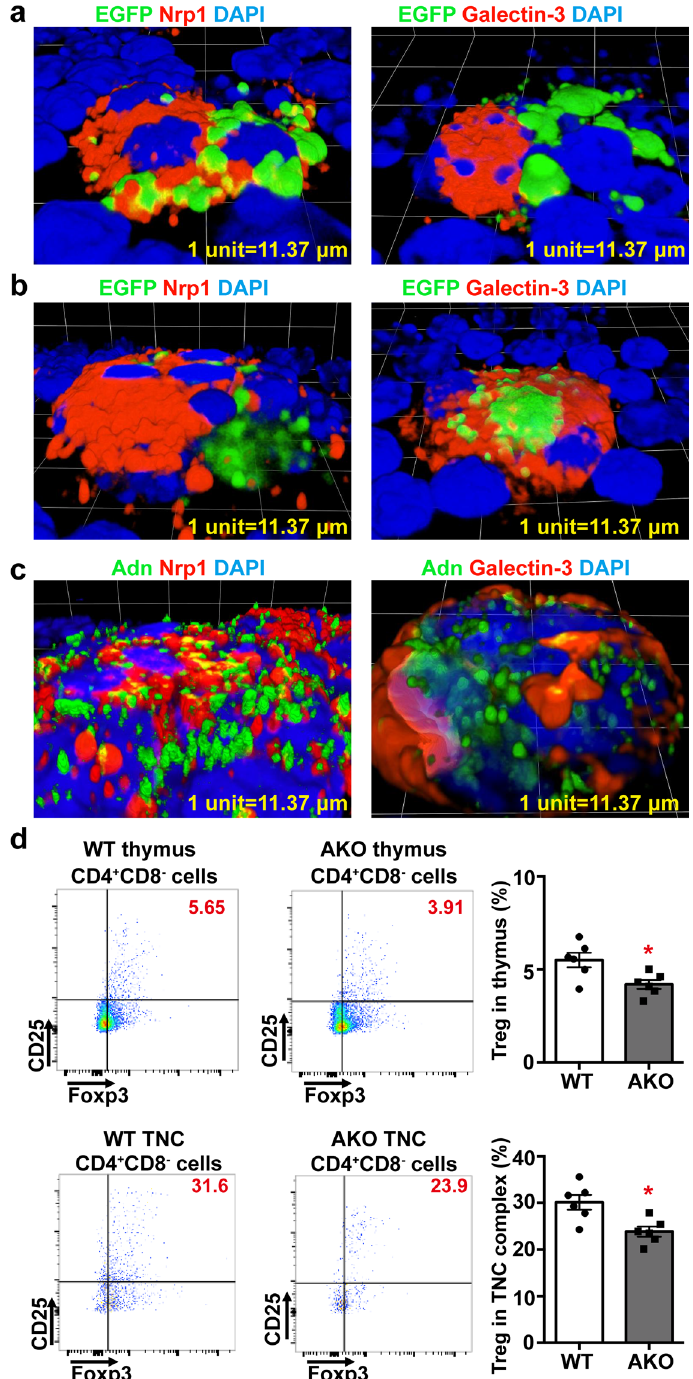
Fig. 4 Mice lacking adiponectin show reduced number of tTreg in thymus and TNC complexes. a Adiponectin-expressing EGFP + cells isolated from Adn- Cre/ROSA mT/mG were administered into 4-week-old WT mice [30000 cells/ mouse via tail vein]. At 15-days after injection, TNC complexes were collected from thymus of the recipient mice for confocal microscopic analyses of the EGFP + cells (green). Immuno fl uorescence counterstaining was performed to detect neuropillin-1 [Nrp1] or galectin-3 (red). b Adiponectin-expressing EGFP + cells isolated from Adn-Cre/ROSA mT/mG mice were administered into 4-week-old AKO mice [30000 cells/ mouse via tail vein]. At 15-days after injection, TNC complexes were collected from thymus of the recipient mice for analyses as in ( a ). c TNC complexes were isolated from 6-week-old WT mice to detect the protein distribution of adiponectin [Adn], Nrp1 and galectin-3 by immuno fl uorescent staining and confocal microscopic analyses. d WT or AKO mice were sacri fi ced at the age of 7 weeks. Flow cytometry was performed to analyze the populations of CD4 + CD8 − CD25 + Foxp + tTreg in the thymus and TNC complexes for comparison. Data are shown as means ± SEM. *, P < 0.05 vs corresponding WT samples ( n = 6 biologically independent samples from different animals of independent